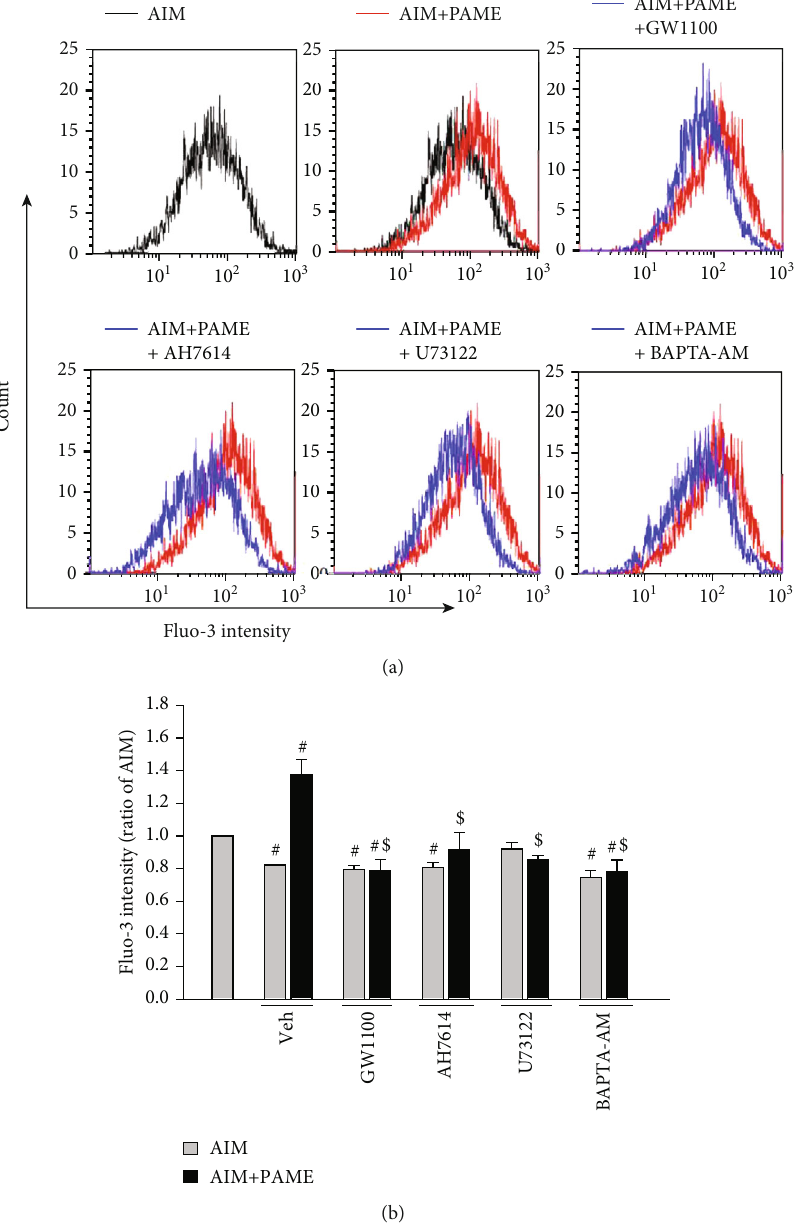
Figure 4: PAME increases intracellular Ca 2+ through stimulating the GPR40/120 and activating the PLC-mediated signaling pathway in rAD-MSCs. Treatment with PAME (50 μ M) in adipogenic induction medium for 12 days increased the intracellular Ca 2+ in rAD-MSCs, and these e ff ects were abolished by cotreatment with GW1100, AH7614, U73122, or BAPTA-AM. (a) Representative histograms show the distribution of Fluo-3 fl uorescence intensities, an indicator of intracellular Ca 2+ . (b) Quantitation fl uorescence intensity of intracellular Ca 2+ levels. All data represent mean ± SEM ( n = 5 ). These antagonists were dissolved in 0.1% DMSO (vehicle). # p < 0 : 05 , versus the AIM group; $ p < 0 : 05 , versus the AIM+PAME group. AIM: adipogenic induction medium; Veh: